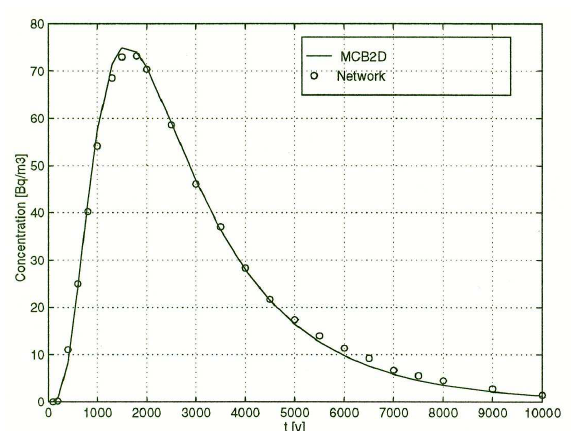
Fig. 4.13: Network with source on node 45, v/R= 9.4 (cid:215) 10 -4 m/d, e test = 14.1%